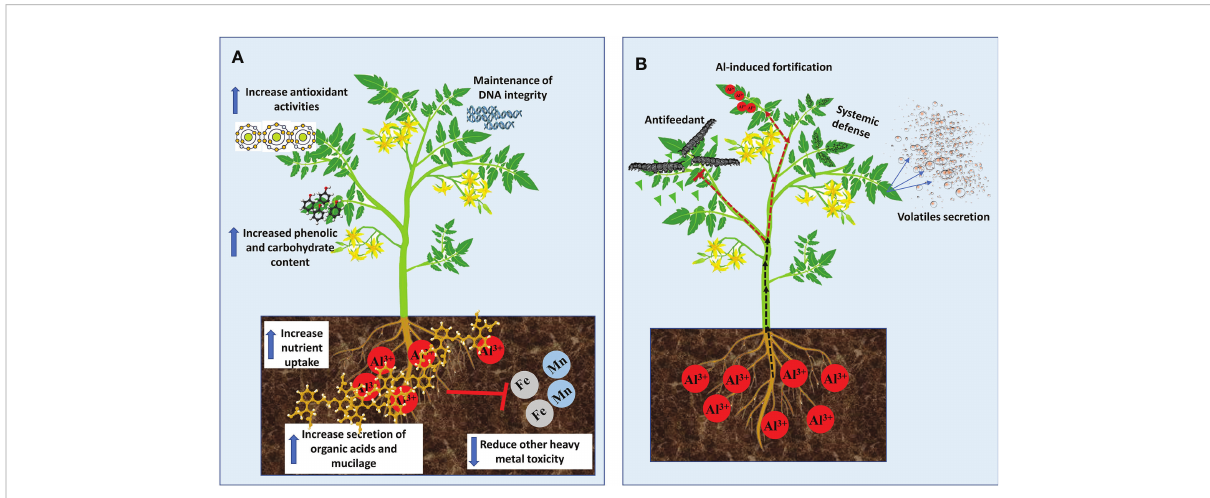
FIGURE 1 Bene fi ts of Aluminum to plant growth and development. (A) Mechanisms of Al-mediated growth simulation. (B) Mechanism of Al-mediated protection against biotic